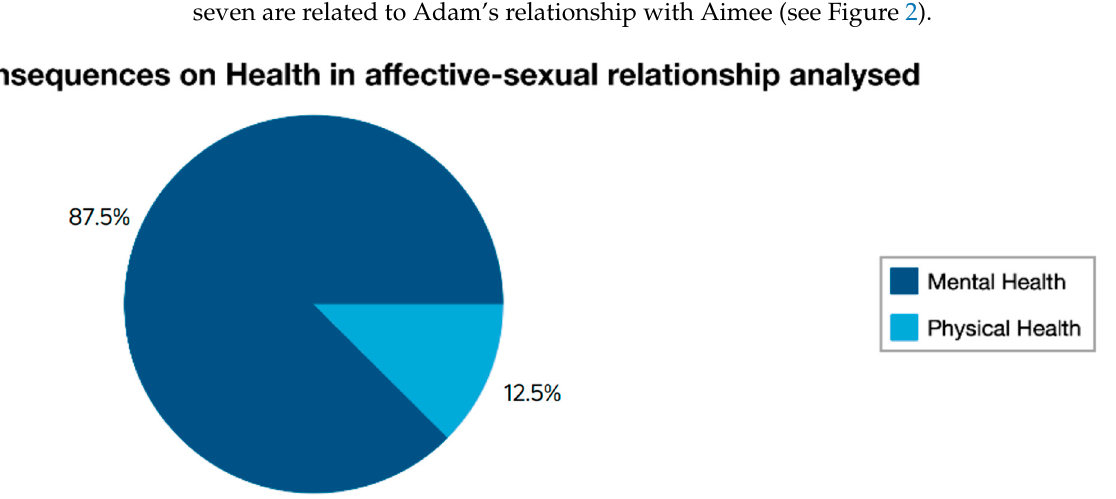
Figure 2. Results concerning the affective-sexual relationships analysed.